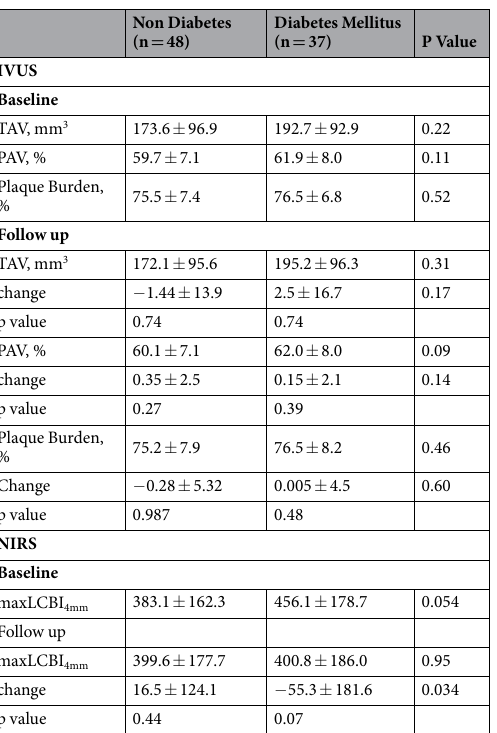
Table 4. IVUS and NIRS findings at baseline and follow up. Values are mean ± SD IVUS intravascular ultrasound, NIRS near infrared spectroscopy, PAV percent atheroma volume, TAV total atheroma volume, maxLCBI4 mm maximal lipid core burden index in a 4 mm